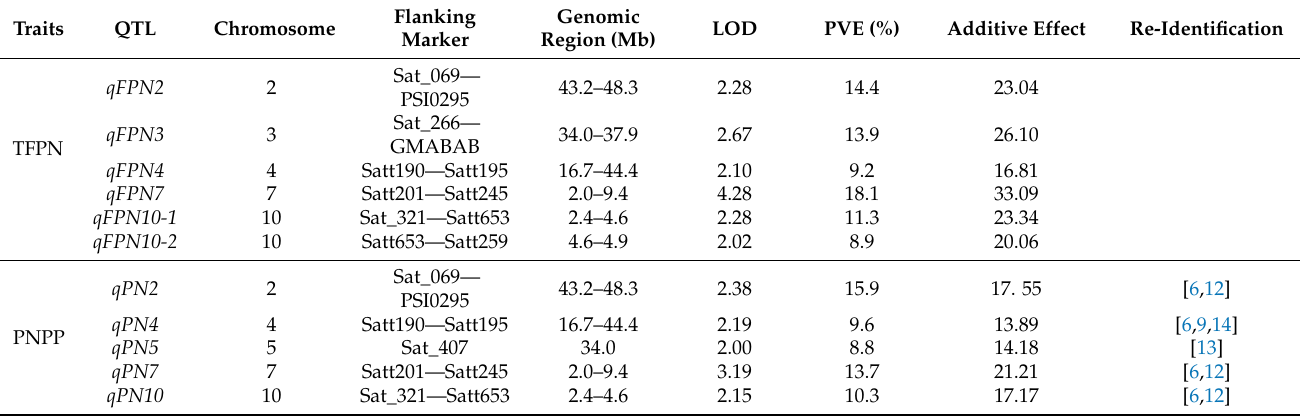
Table 2. QTL information for TFPN and